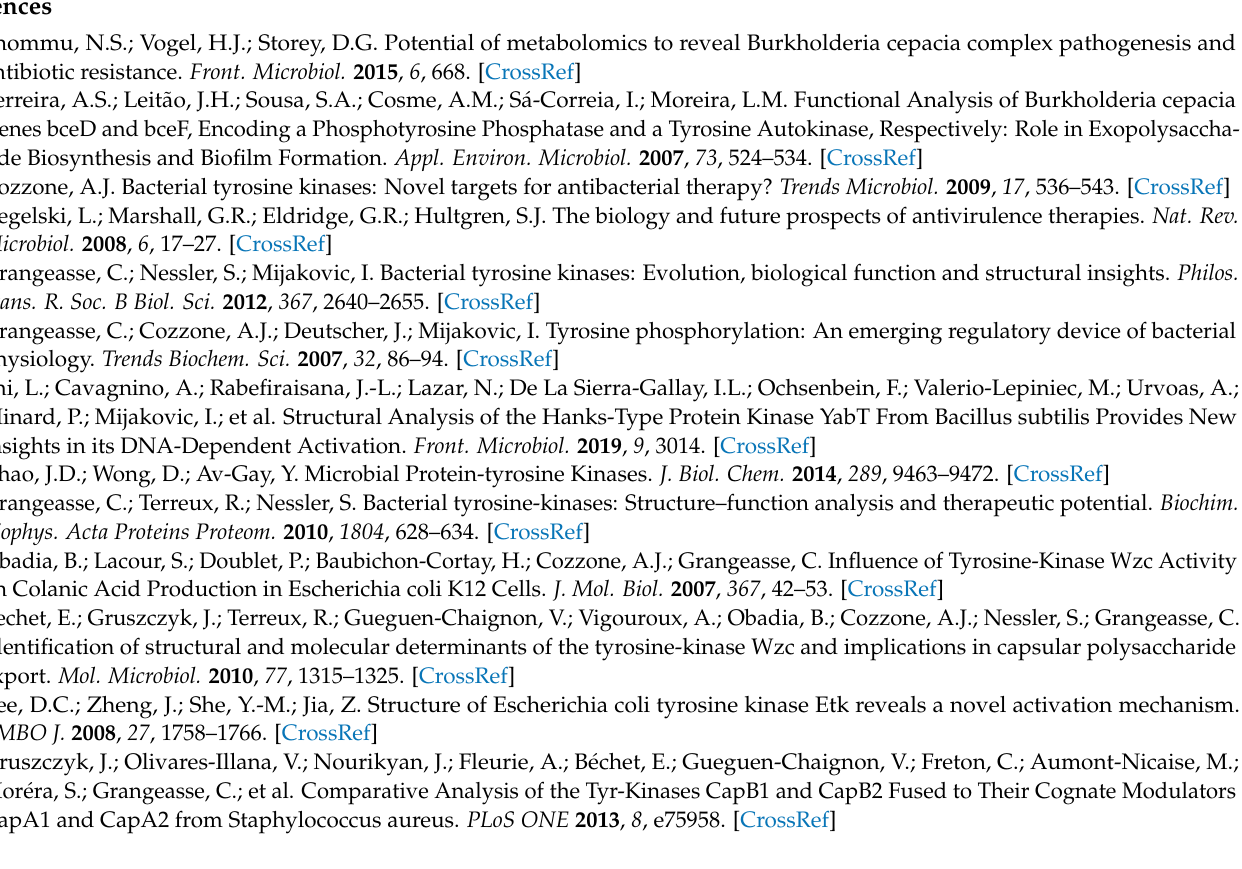
the BceF octamer model versus the BceF dimer, Figure S7: Structural alignment of crystallographic dimers of BY-kinases, Figure S8: The isolated CapAB kinase domain forms a dimer in the crystal structure, Figure S9: The isolated Etk kinase domain forms a dimer in the crystal